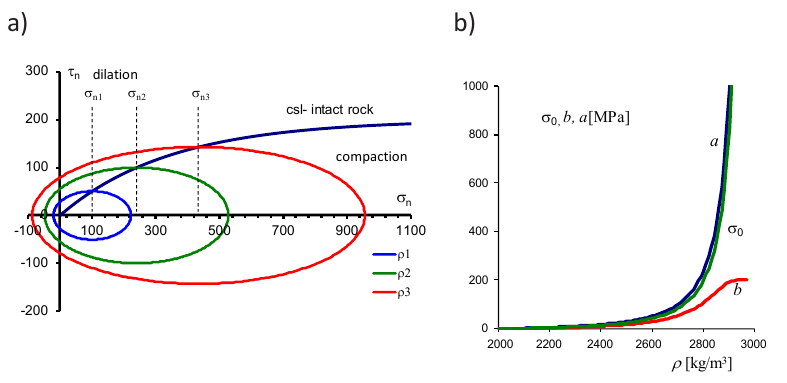
and semi-major and semi- 0